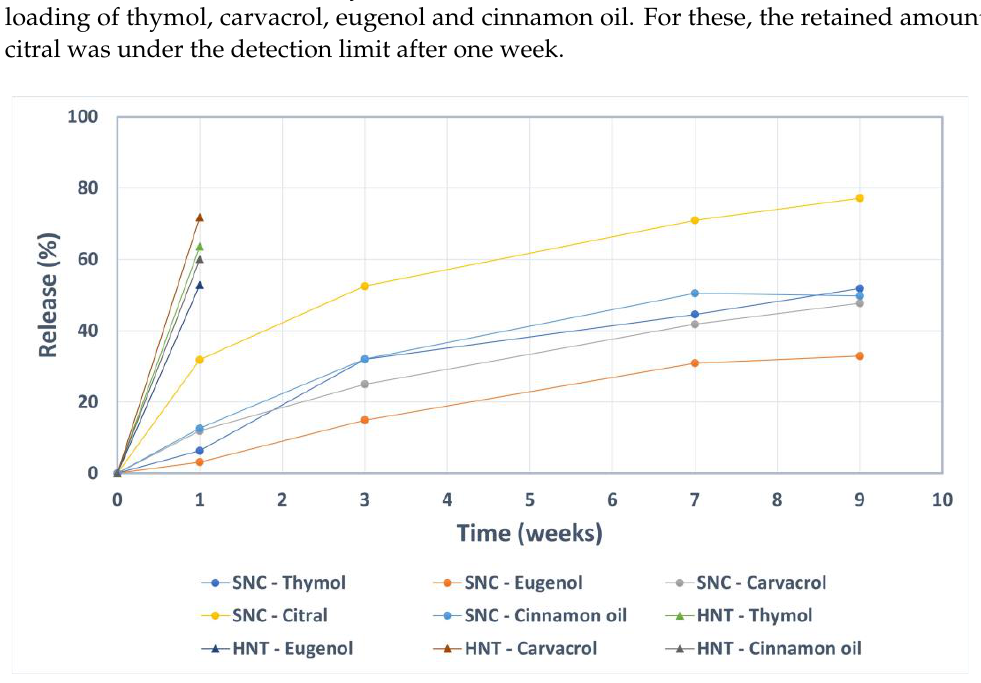
Figure 4. Prolonged release of the active compounds encapsulated into silica nanocarriers (SNC) compared to the control nanocarriers (halloysite nanotubes, HNT). Table 2. Physico-chemical properties of the active compounds obtained from